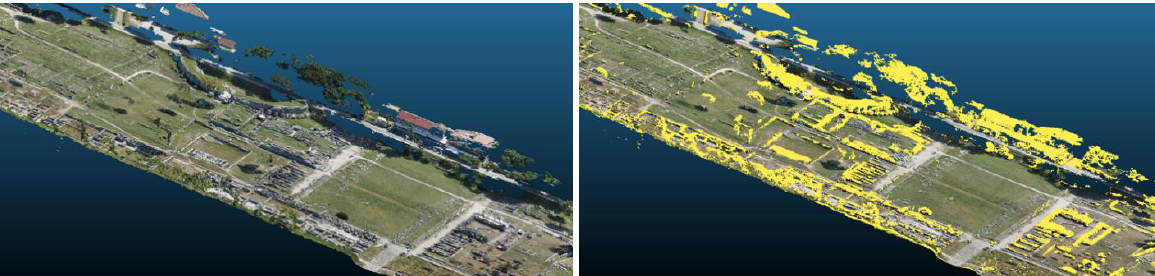
Figure 5: 3D point cloud of the archaeological site of Paestum (left) and segmentation to separate bare earth and man-made structures (right).